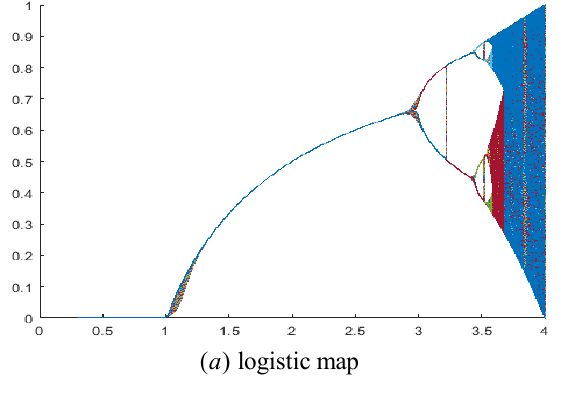
Figure 1. Bifurcation diagram.